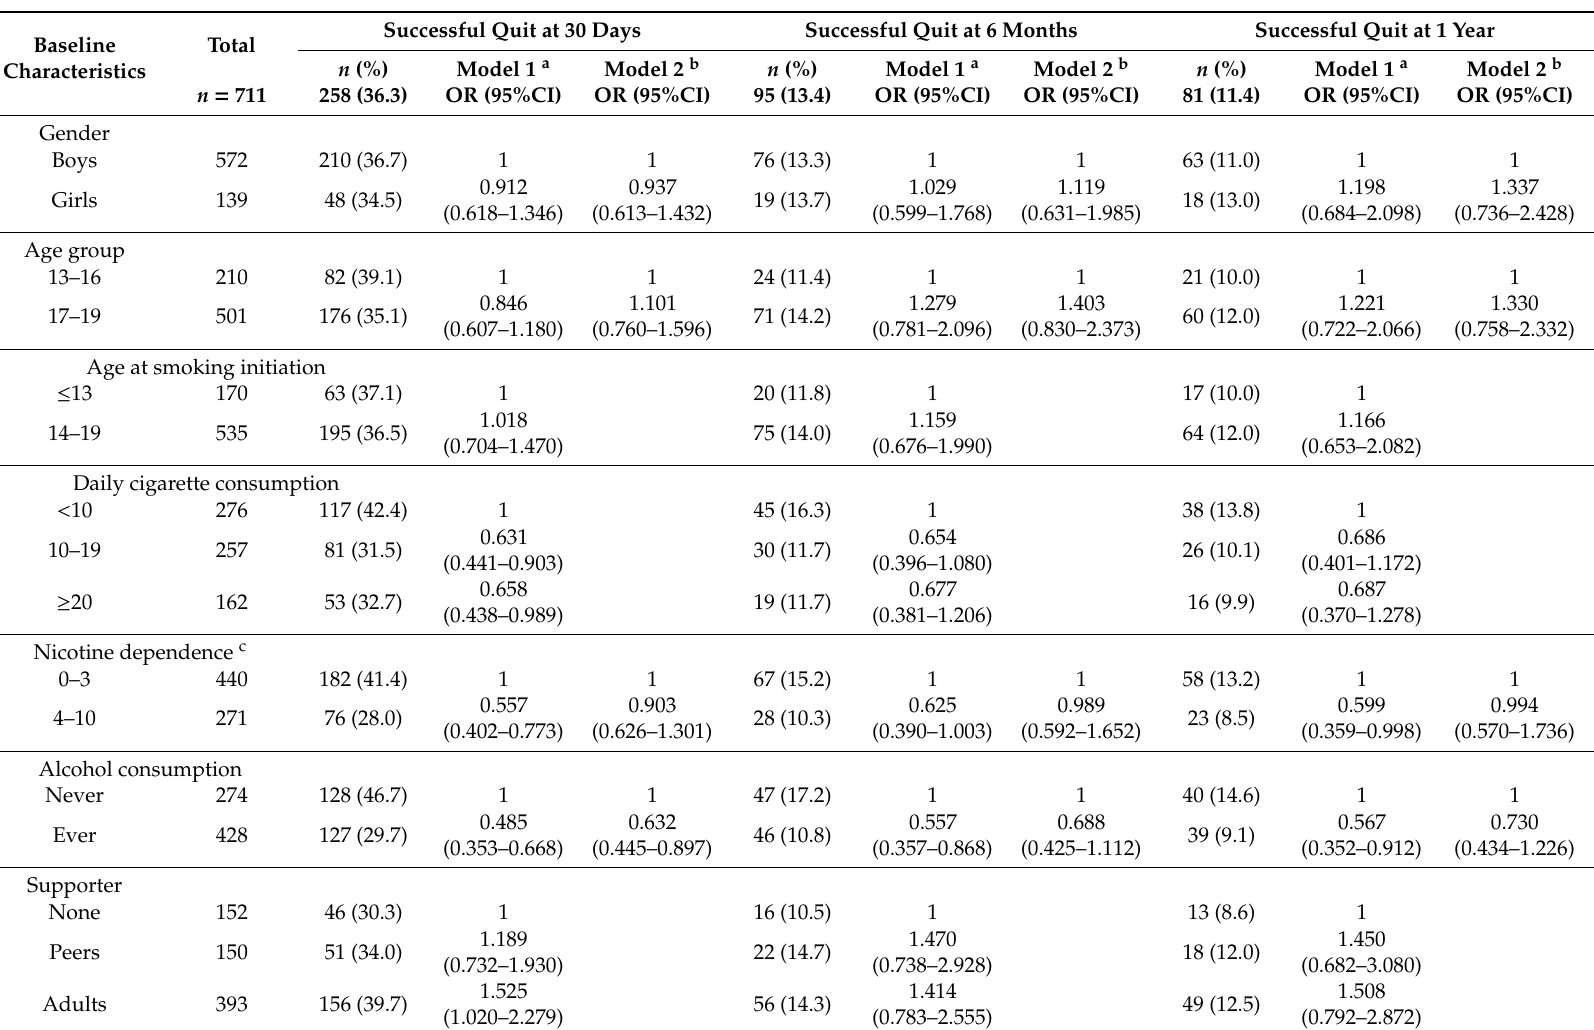
Table 2. Odds ratios and confidence intervals of potential factors associated with successful quit among adolescent Quitline users (Overall).